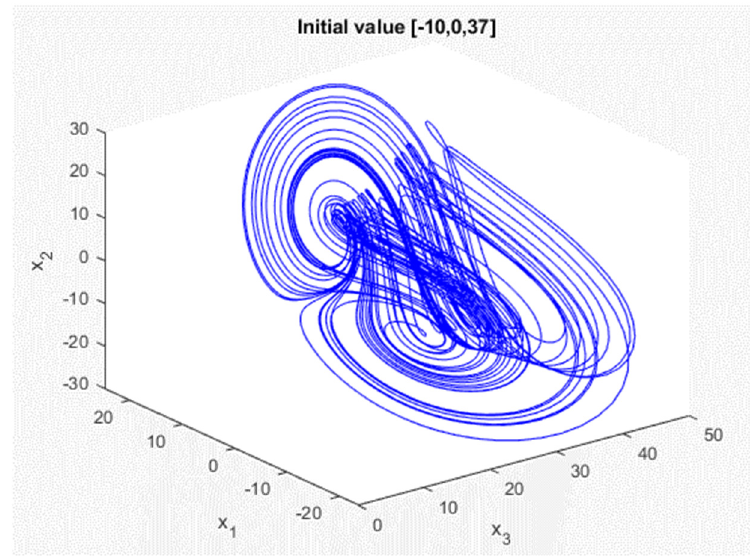
Figure 1. Generalized Lorenz chaotic system response of master.